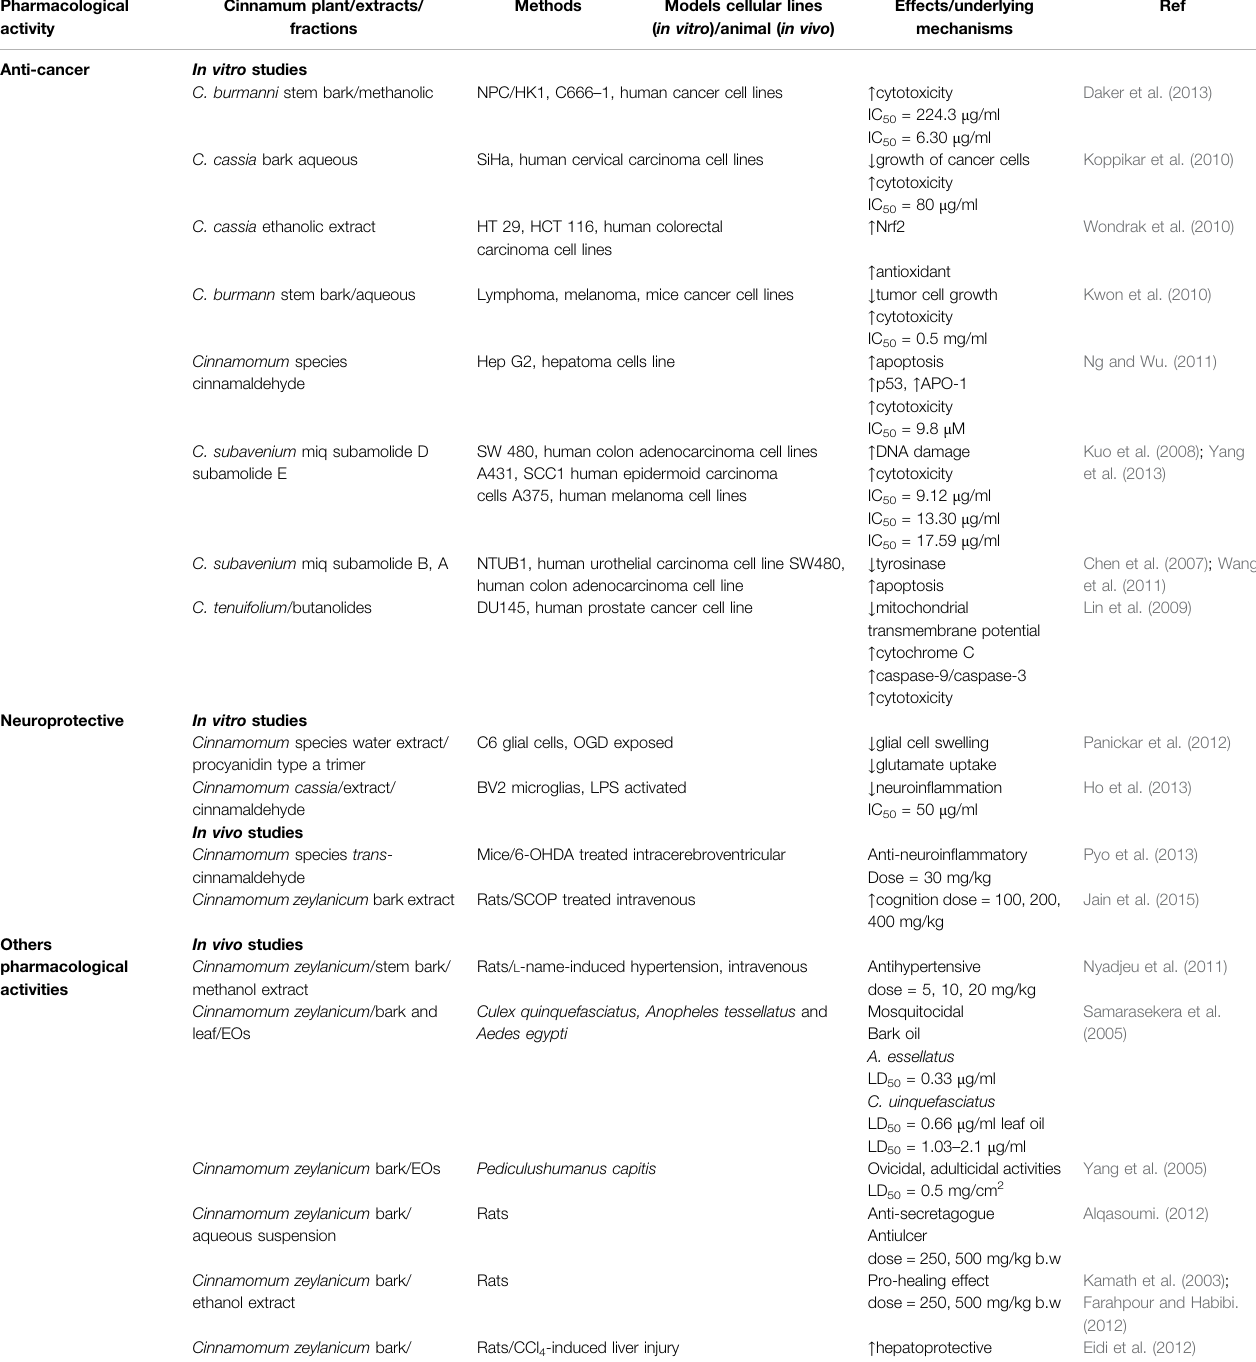
TABLE 2 | ( Continued ) Preclinical pharmacological activities of Cinnamomum genus.